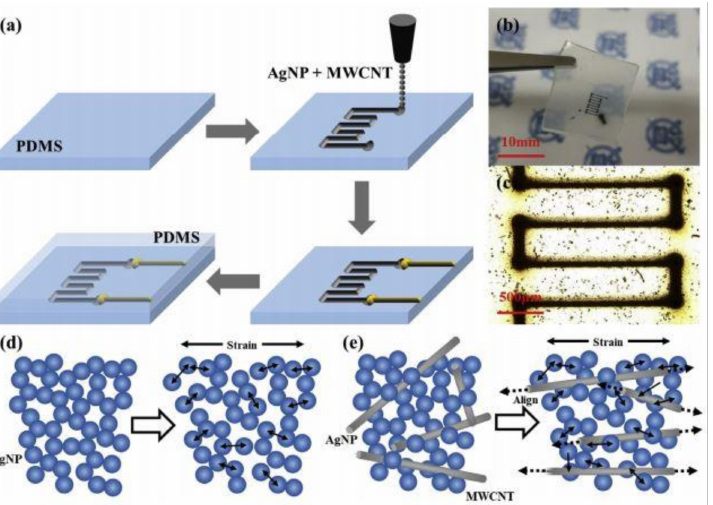
Figure 6. ( a ) Schematic diagram of the fabrication steps of the Ag NP/MWCNT-based sensors. ( b ) Photograph and ( c ) optical images of the fabricated samples. ( d ) Schematic diagram of the operating principle of the nanocomposite-based strain sensors and ( e ) Movement of the MWCNTs and silver nanopartciles under stretched condition. [112]. Reproduced from Min, S.H.; Lee,